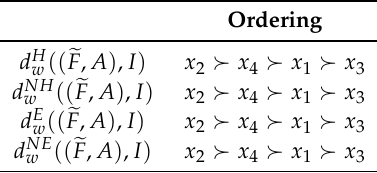
Table 4. Ordering the alternatives.